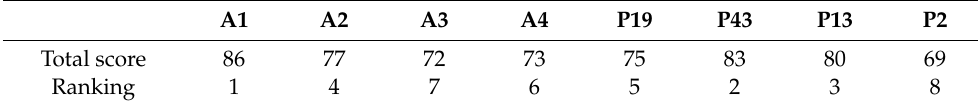
Table 12. The result of perceptual evaluation for the eight healing